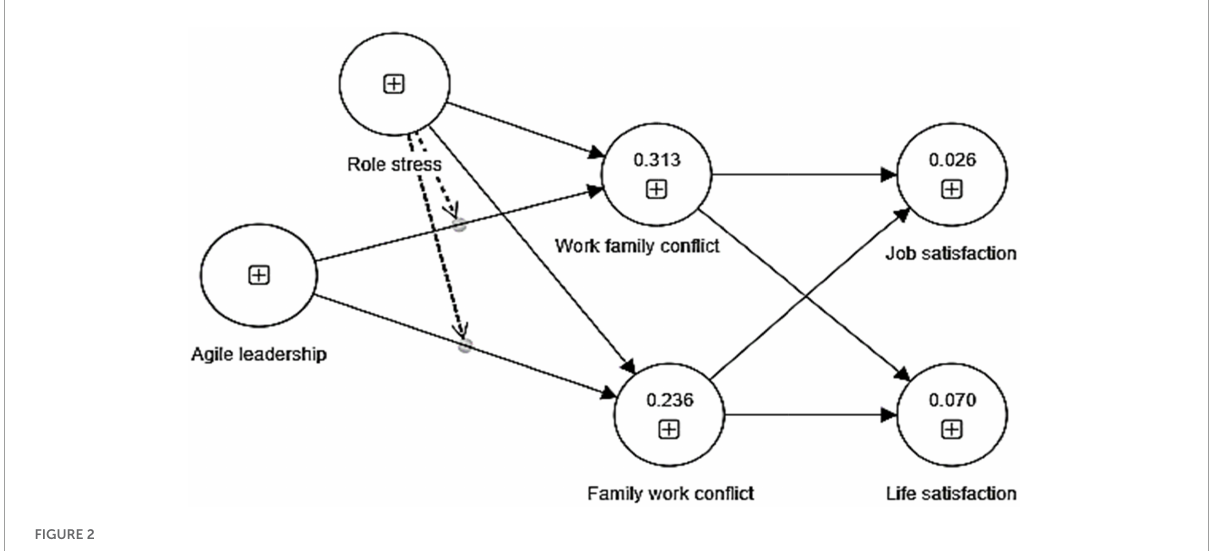
FIGURE2 Measurement model.